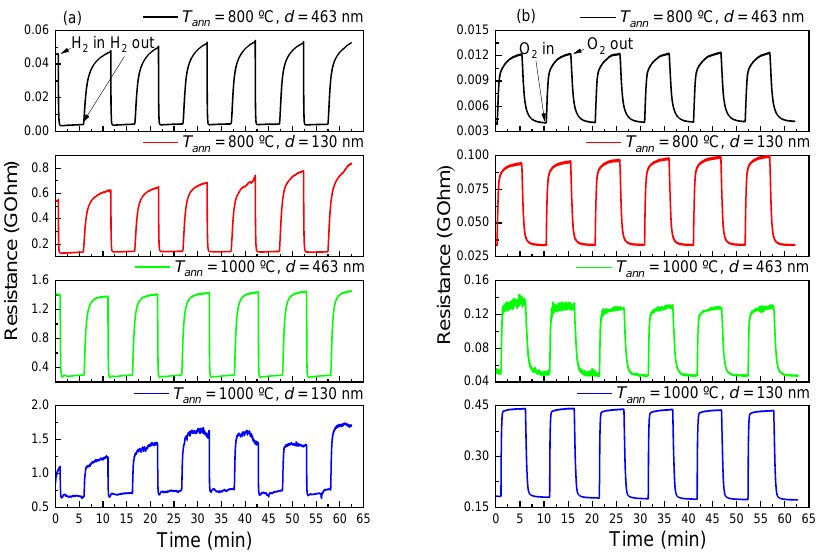
Figure 9. Time dependences of the TiO 2 thin films resistances upon exposure to 1 vol. % H 2 at T oper = 600 °C ( a ) and upon exposure to 40 vol. % O 2 at T oper = 750 °C ( b ).